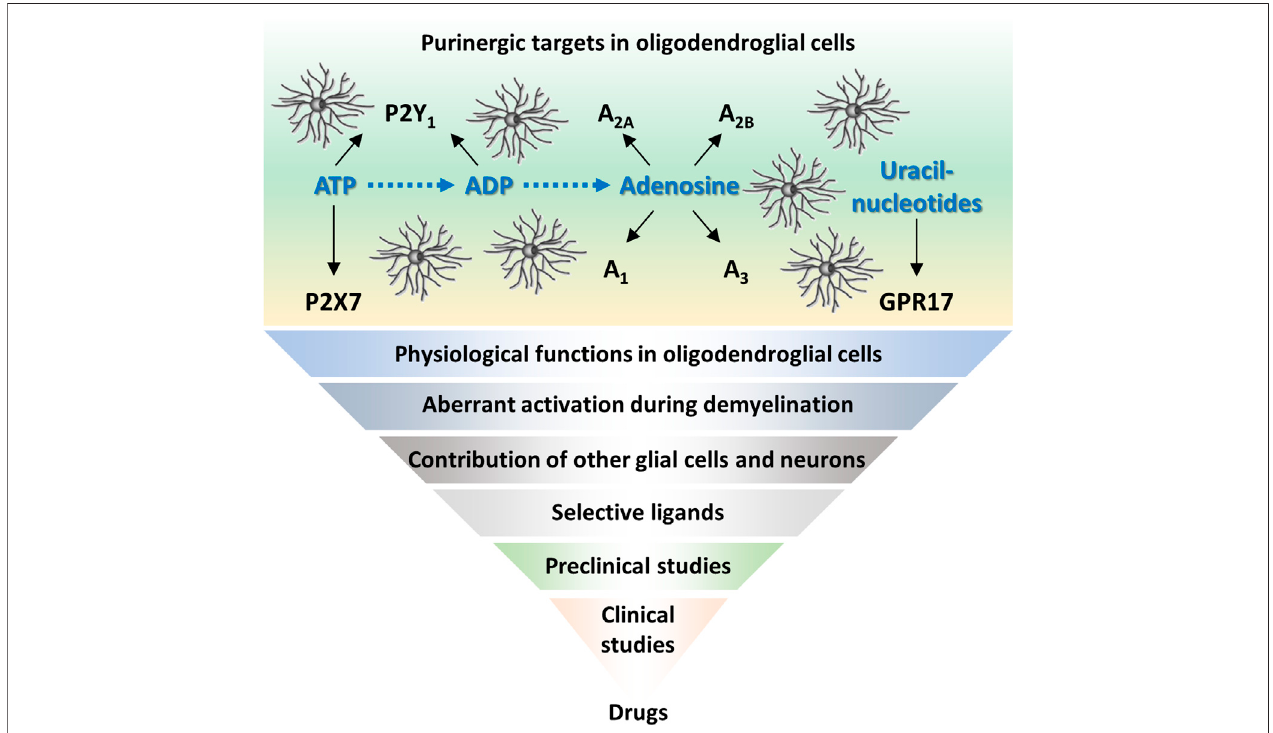
FIGURE 1 | Purinergic receptors in oligodendrocyte progenitors as promising targets in multiple sclerosis. Schematic representation of purinergic receptors expressed in oligodendroglial cells and their ligands. To develop new purinergic-based drugs for remyelination, further efforts should be done in basic research, to provide robust data to be translated into